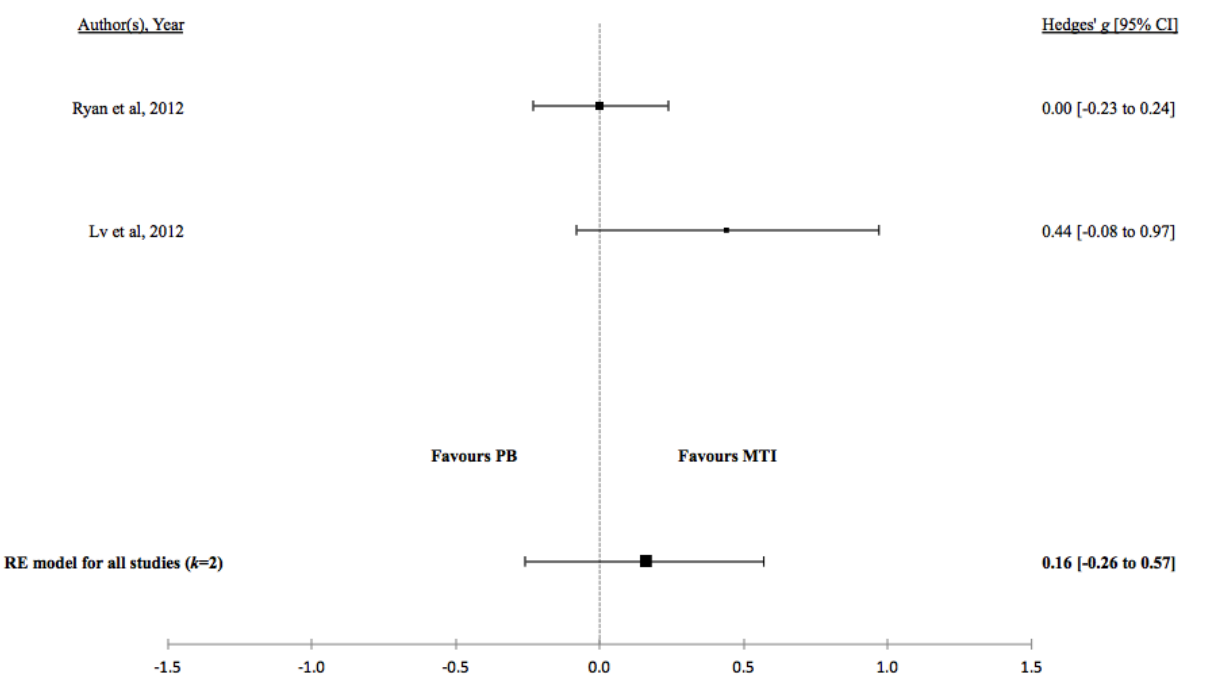
Figure 9. Forest plot of the standardized mean difference in asthma control between MTI and paper-based group (PB). MTI: mobile technology intervention.